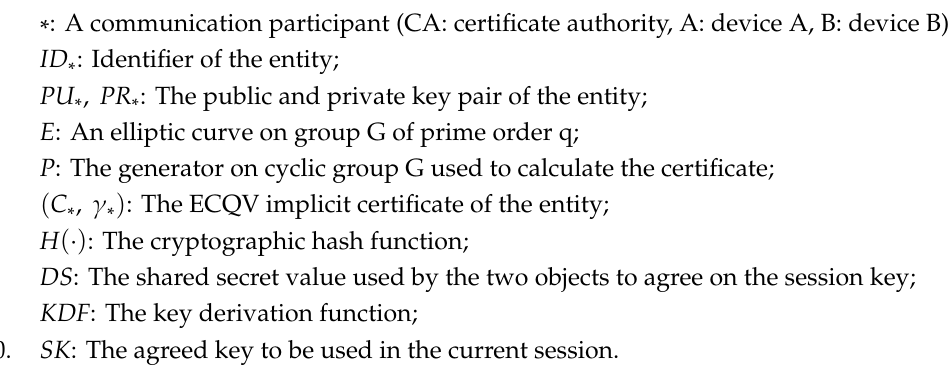
Figure 5. The scenario of Scheme 1. ECQV, elliptic curve Qu–Vanstone.